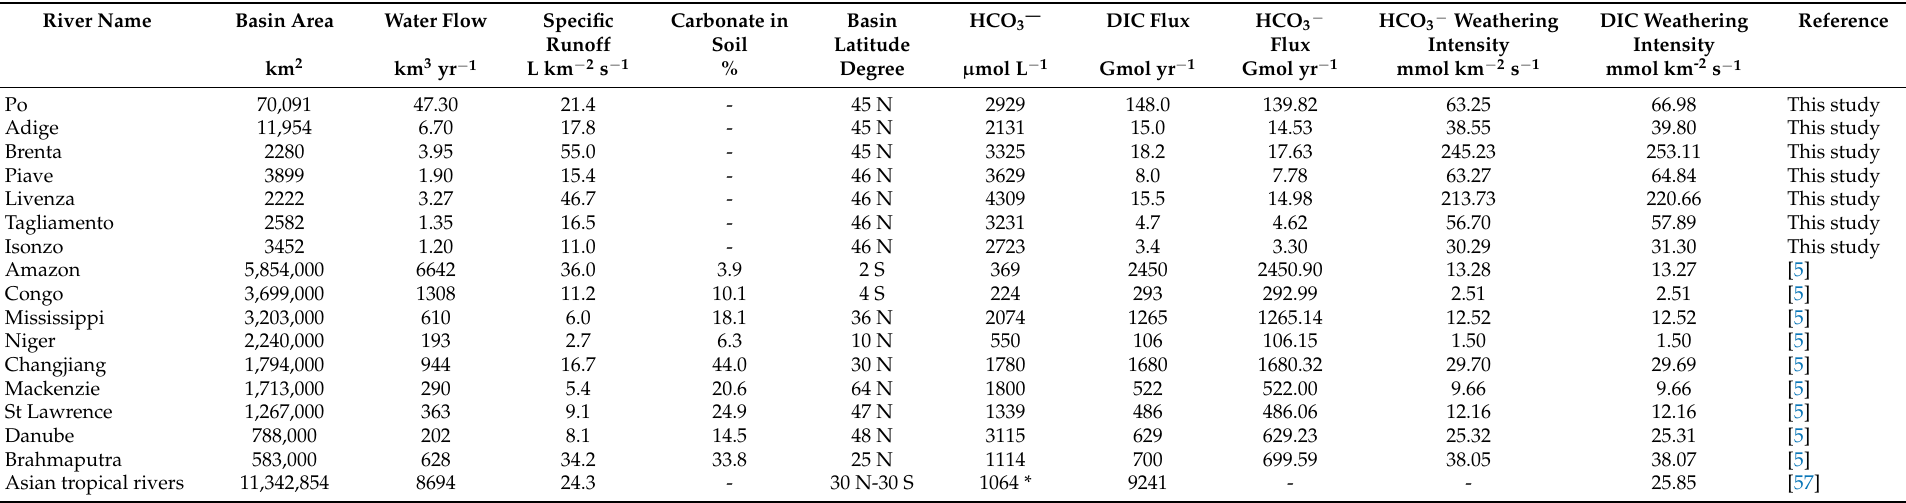
Table A3. Comparison of different river fluxes and weathering intensities of dissolved inorganic carbon and bicarbonates in this study (2010–2019) and in the